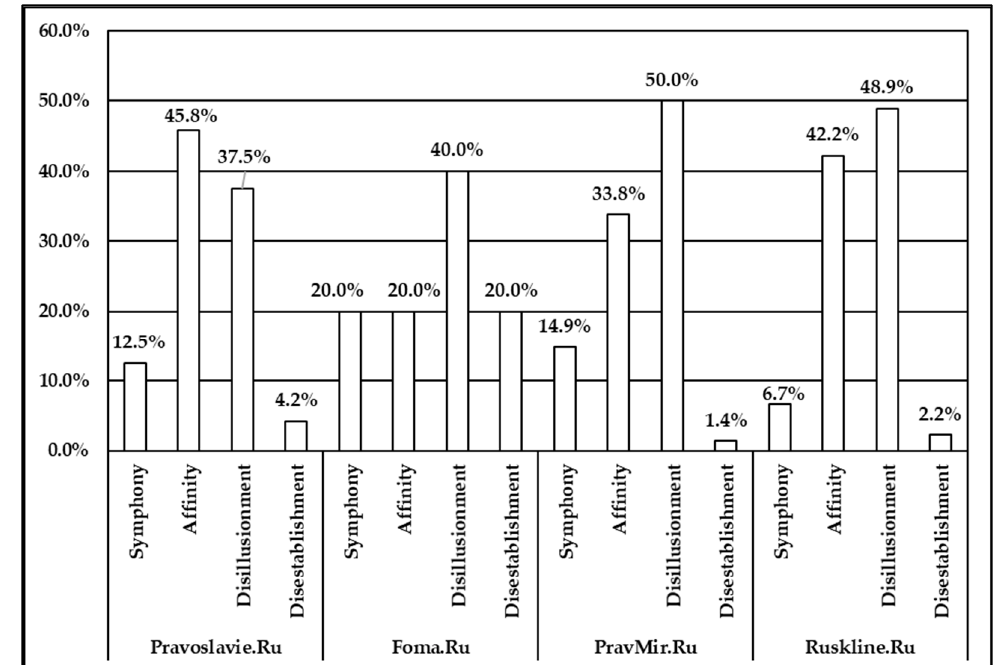
Figure 5. Dominant church–state relations frames, % of articles where found by portal.